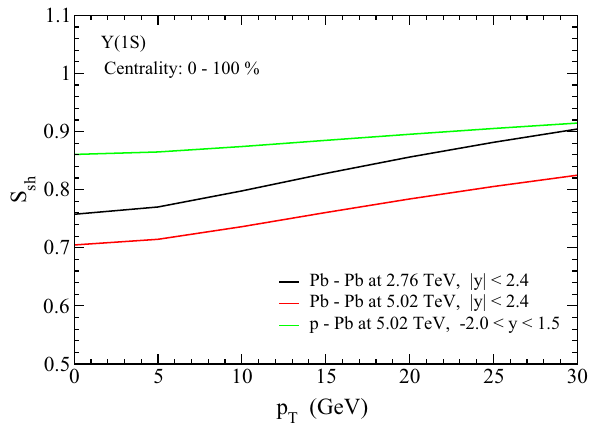
Fig. 7 Variation of ϒ( 1 S ) shadowing factor ( S sh ) versus transverse momentum ( p T ) plotted corresponding to central rapidity region for √ s NN = 2 . 76 , 5 . 02 TeV and p–Pb at Pb–Pb at